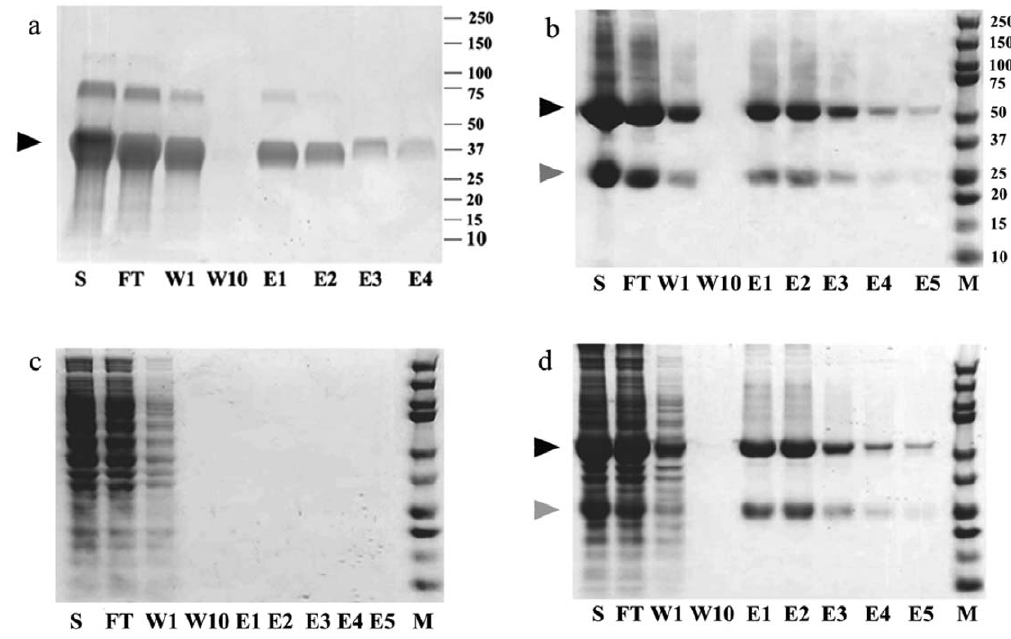
Figure 3. Purification of biotinylated protein G and IgG using 8-aa-loop-H127C mutein-agarose matrix. Excess amounts of biotinylated proteins were loaded to the column. Panel a: Biotinylated protein G with an apparent molecular mass of 37 kDa is marked by arrowhead. Some biotinylated protein G molecules are in oligomeric state with higher molecular masses. Panel b: The 54- and 25-kDa protein bands are the biotinylated heavy (marked by closed arrowhead) and light chains (marked by gray arrowhead) of IgG, respectively. Panel c: HeLa cell extract was applied to the 8-aa-loop-H127C mutein-agarose matrix. Panel d: Biotinylated IgG mixed with HeLa cell extract. S: Sample before purification, FT, W, and E: Flow-through, wash and elution fractions. M: Molecular weight markers.